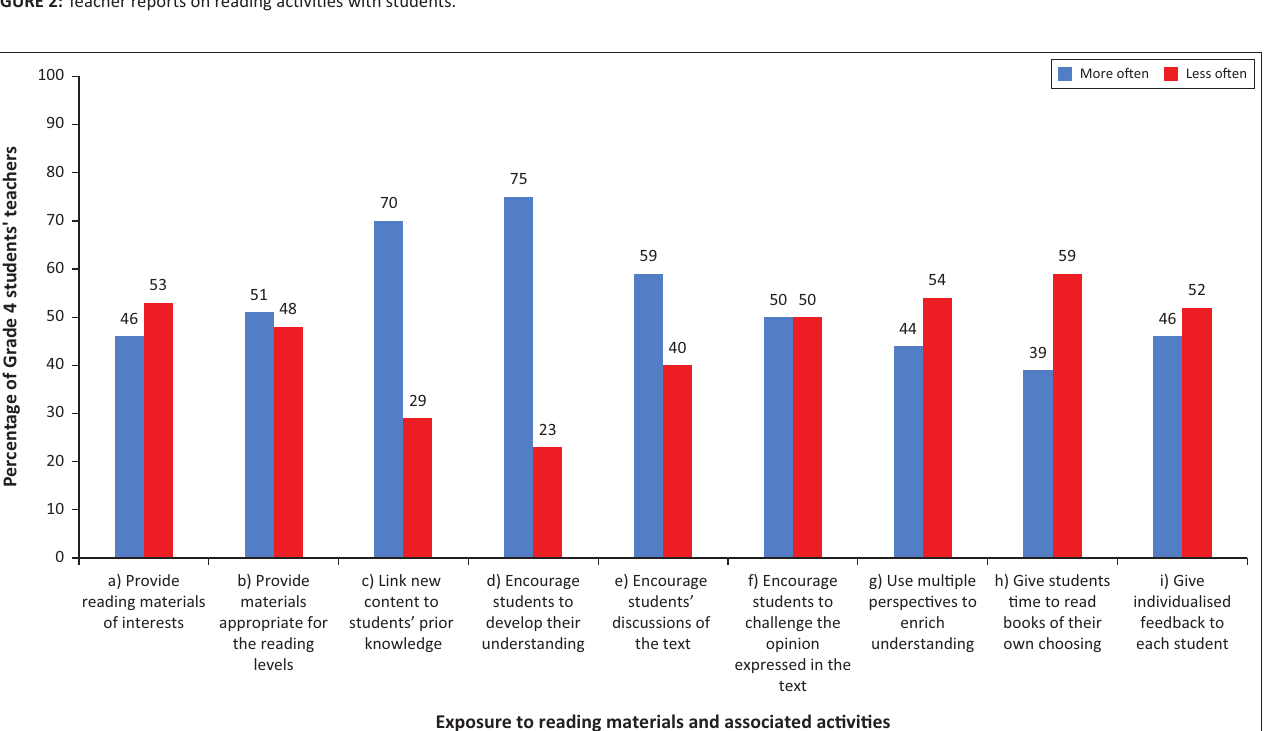
FIGURE 3: Teacher reports of exposure to reading materials and associated